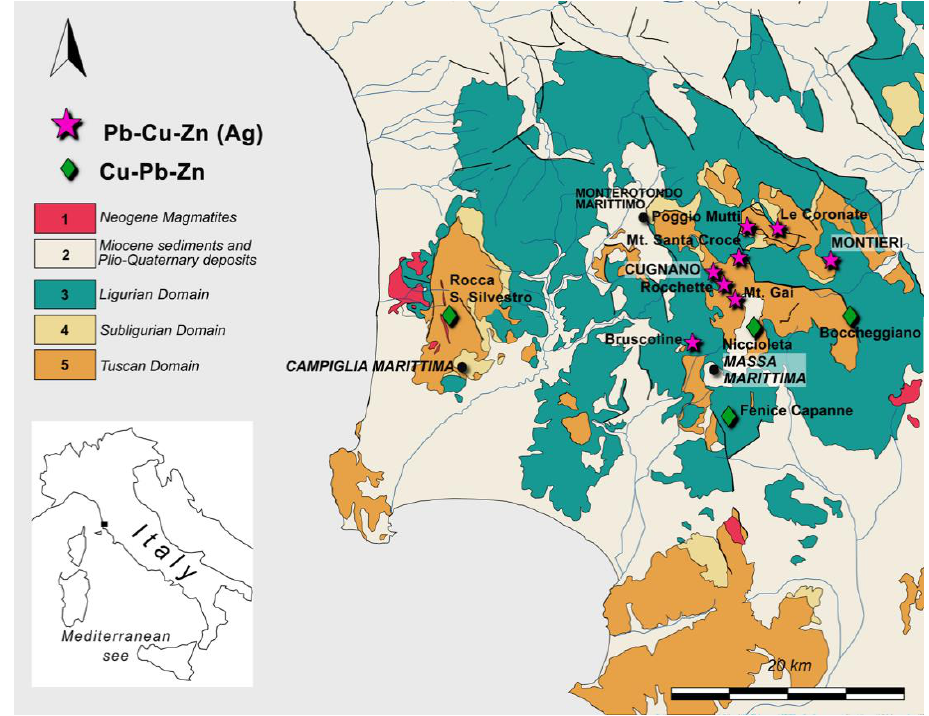
Figure 1. Schematic geologic map of southern Tuscany with locations of the main ore deposits. (1) Acid igneous or subvolcanic rocks, dykes and sills, volcanic rocks, and pyroclastic deposits; (2) conglomerates, sandstones, clays, evaporites, and sands; (3) limestones, marl, sandstones, and mudstones (late Cretaceous–Early Paleocene), shales, siltstones, and limestones (early Cretaceous), ophiolites (Jurassic); (4) sandstones, conglomerates, shales, limestones, and siltstones (Paleocene– Miocene); (5) from bottom: limestone formations, radiolarites, shales, marls, calcilutites, calcarenites, and sandstone flysh (late Triassic–early